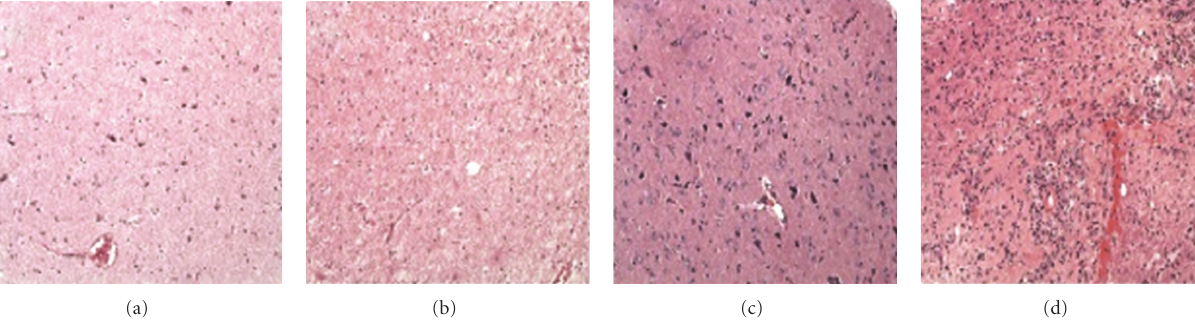
Figure 3: Histopathology of brain biopsies. (a) The cortex from patient A is essentially unremarkable. There is no neuronal loss or gliosis, no tumor, and no inflammation. H&E, 200x. (b) The white matter from patient A is markedly gliotic, with many large astrocytes, and is also vacuolated from edema. H&E, 200x. (c) The cortex from patient B is similarly unremarkable. H&E, 200x. (d) The white matter from patient B has perivascular infiltrates of foamy macrophages along with many large astrocytes. H&E,